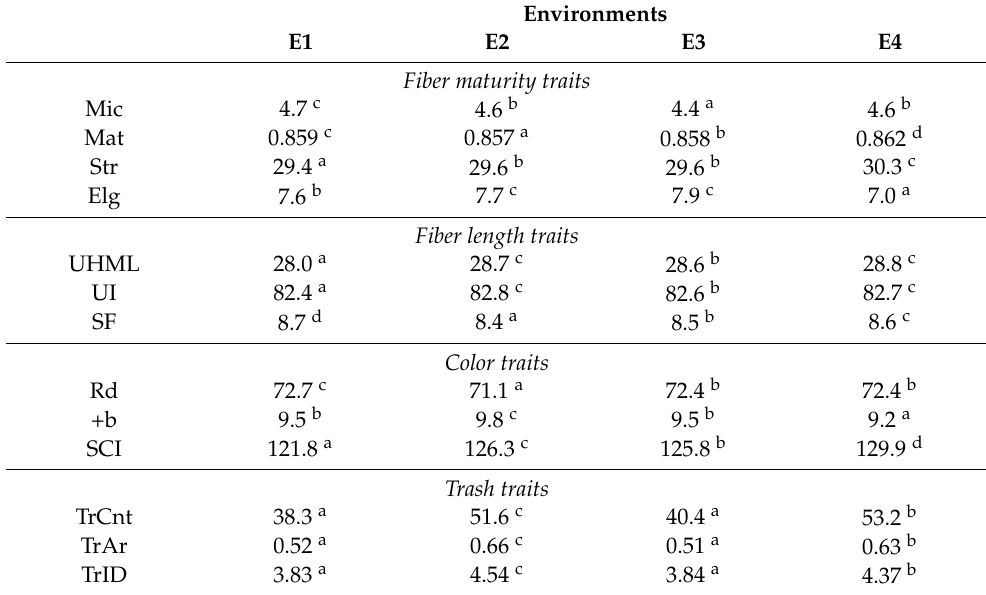
Table 4. Values in each testing environment averaged across five years in quality attributes of